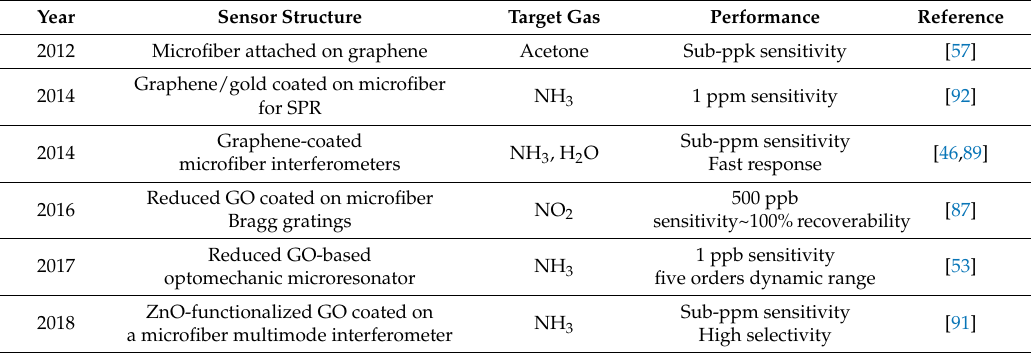
Table 1. Major progress in the optical graphene gas sensors based on